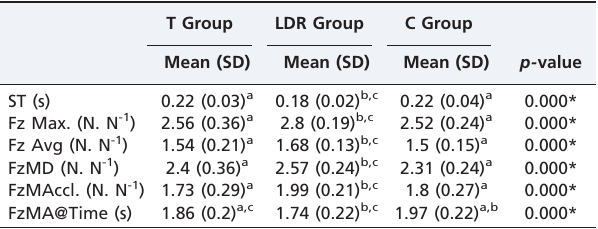
Table 1 - The means (SD) of kinetic variables for the groups and the comparison among the triathlete group, the long-distance runner group, and the control